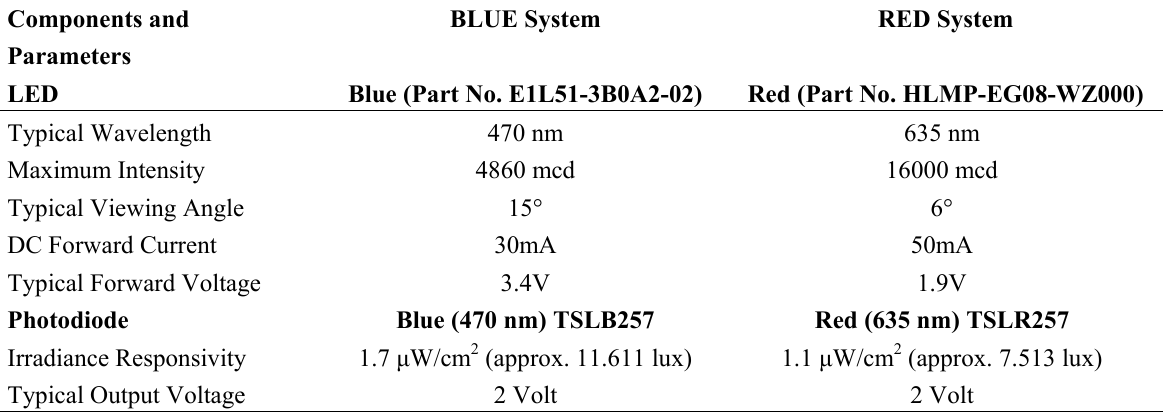
Table 4. Optical Components and Parameters [51].